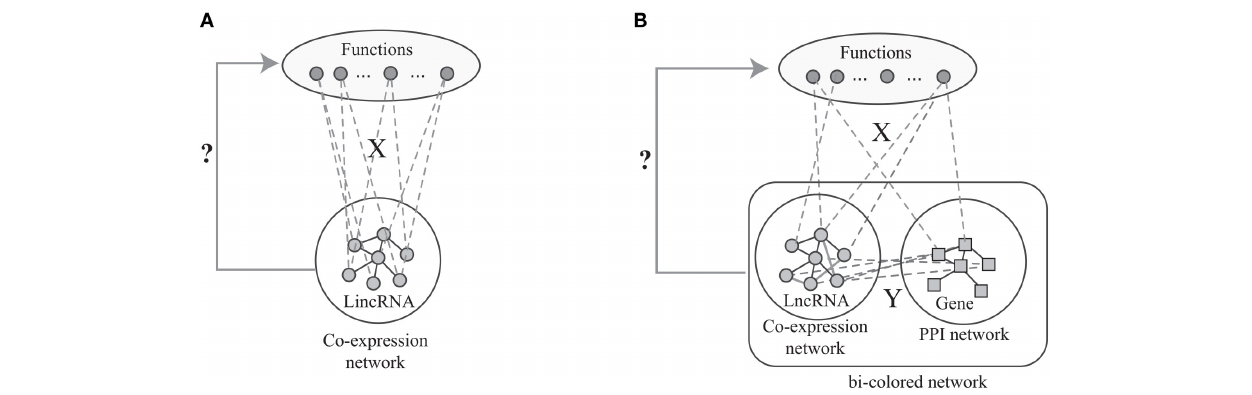
FIGURE 1 | The flowchart of the current algorithms based on network analysis: (A) label propagation method based on the lncRNA co-expression network, (B) label propagation method based on the bio-colored network.